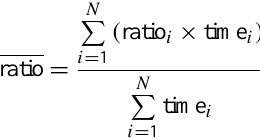
Figure 2. Time dependent ratio